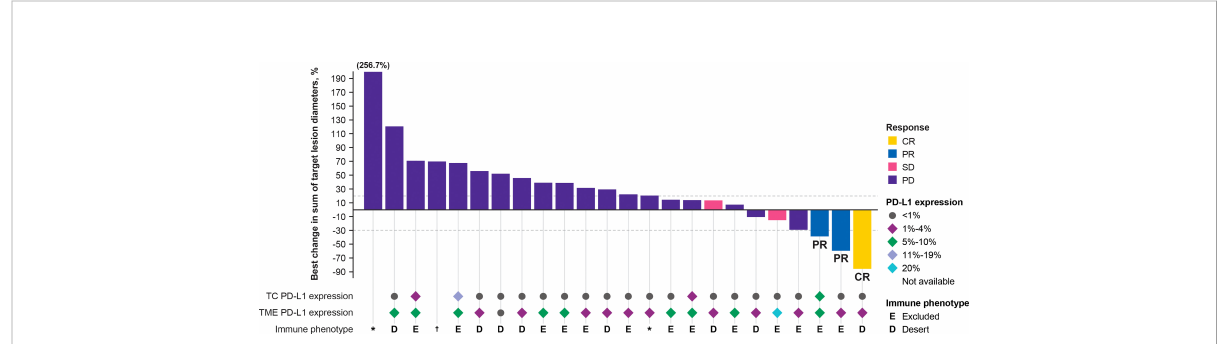
FIGURE 2 Best change in target lesions from baseline assessed by independent review committee. Patients with a BOR of NE (n = 7) are not included in this fi gure. Two additional patients with a BOR of PD were not included in this fi gure as they lacked a valid postbaseline target lesion measurement. *Non-evaluable immune phenotype. † Sample not available for processing by pathologist. BOR, best overall response; CR, complete response; NE, not evaluable; PD, progressive disease; PD-L1, programmed death ligand 1; PR, partial response; SD, stable disease; TC, tumor cell; TME, tumor microenvironment.